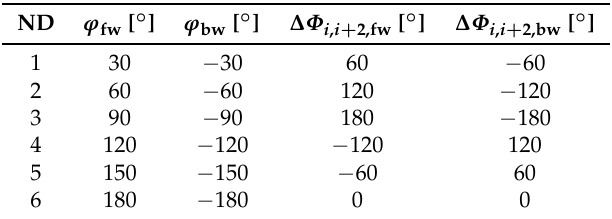
Table 2. Forward and backward inter blade phase angle ϕ and measurable blade phase angle between SG-applied blades ∆ Φ i , i + 1 .